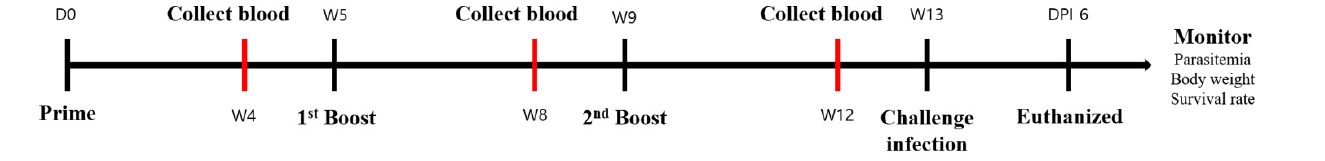
Figure A2 . A schematic diagram depicting animal experimental schedule. Immunization intervals, blood collection, challenge infection, and euthanasia time points are indicated.